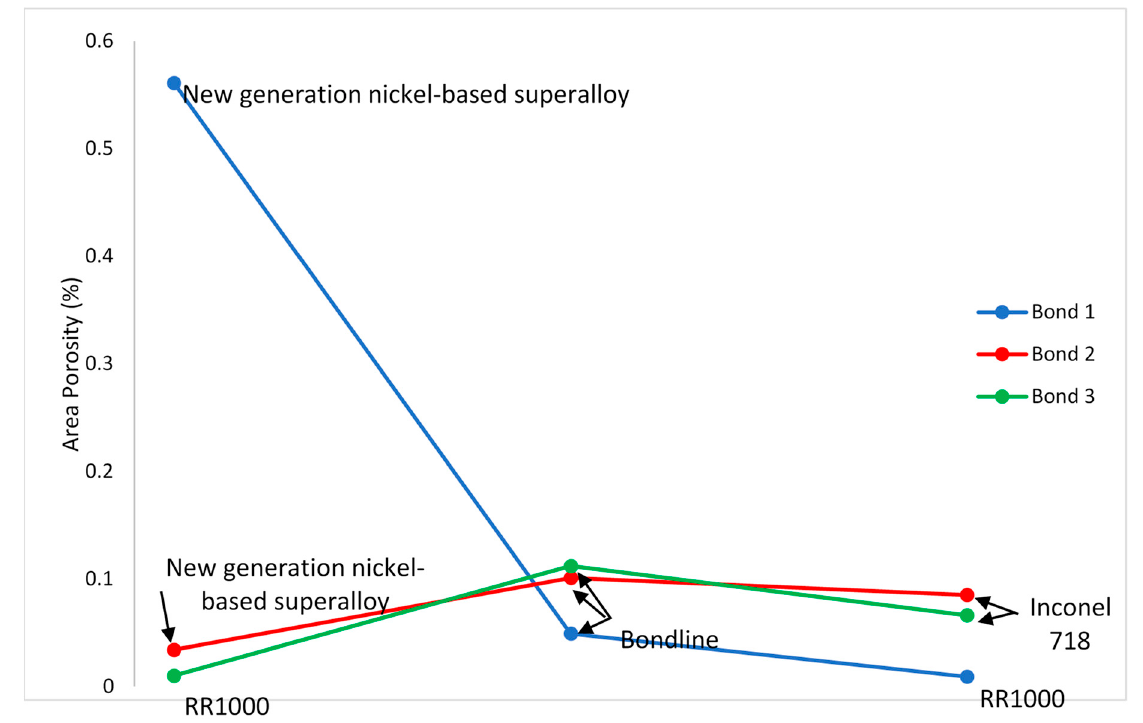
Figure 12. Graph detailing porosity variation throughout bonds . Table 3. Base material porosity .